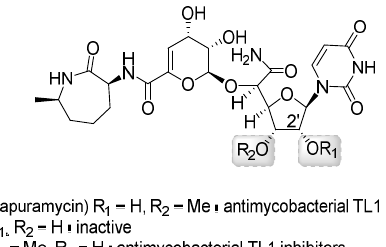
Figure 8. Structures of capuramycin analogs generated through total synthesis and a summary of structure–activity relationship.